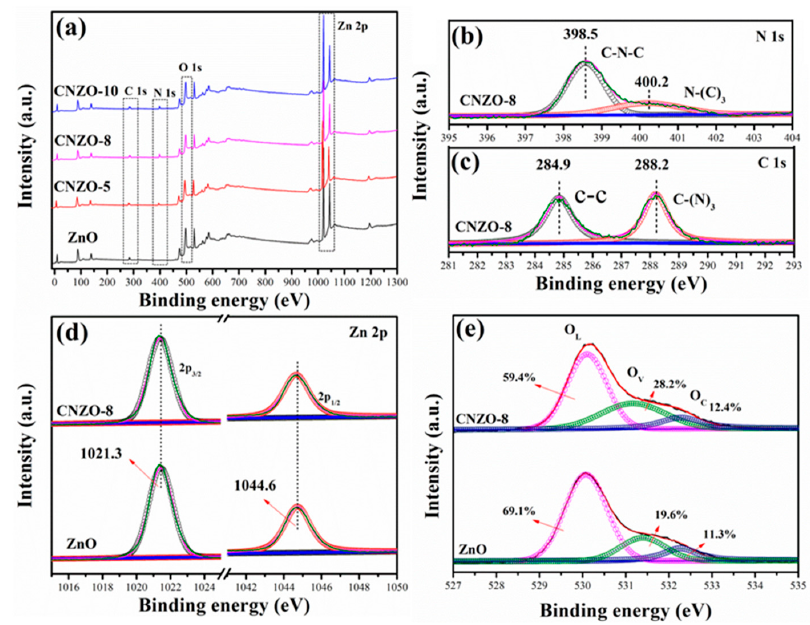
Figure 7. XPS survey spectra ( a ) of ZnO, CNZO-5, CNZO-8 and CNZO-10, XPS high-resolution spectrum and fitted curves of N 1s ( b ), C 1s ( c ) and Zn 2p ( d ) between ZnO and CNZO-8, O 1s ( e ) of ZnO, and CNZO-8.